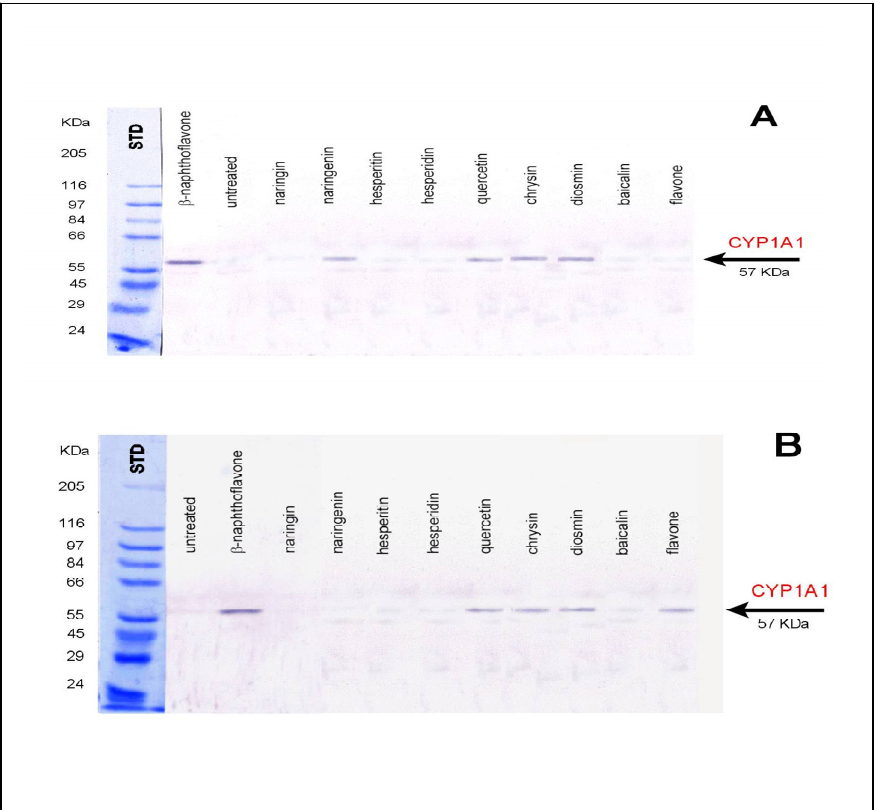
Figure 1. Immunodetection of CYP1A1 in colon ( A ) and liver ( B ) microsomes from flavonoid treated rats. Electrophoresed microsomal proteins (7.5 µg/well) were transferred to Immobilon-P membrane and probed with antibody against